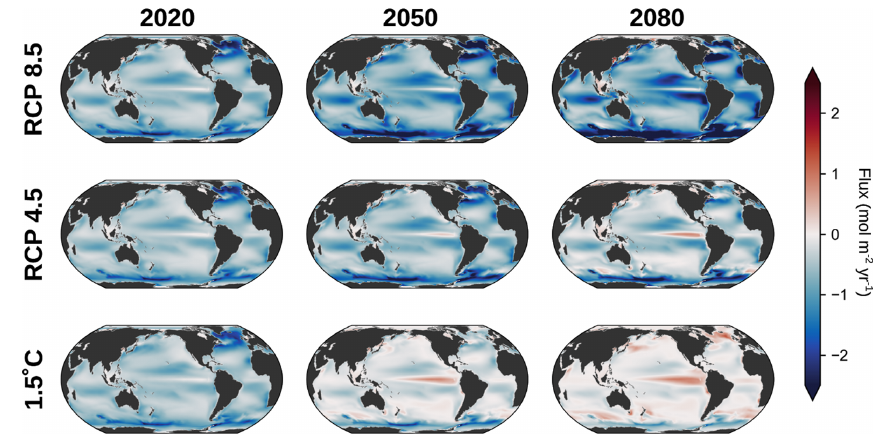
Figure 1. CESM ensemble-mean air–sea flux of anthropogenic carbon (mol C ant m − 2 yr − 1 ; positive is red and denotes flux to the atmo- sphere). Each row is a scenario, and each column represents a year. Emission mitigation is greatest at the bottom of each column.